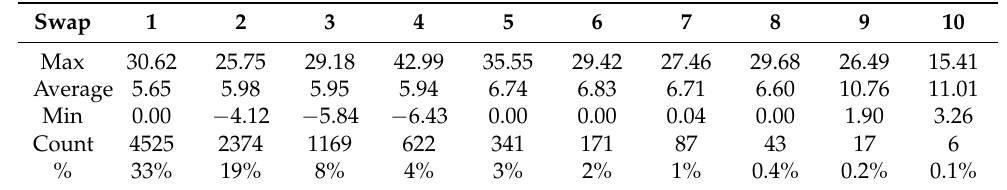
Table 4. Cost of the link swaps in MST-to-TSP during the algorithm with Dots data.